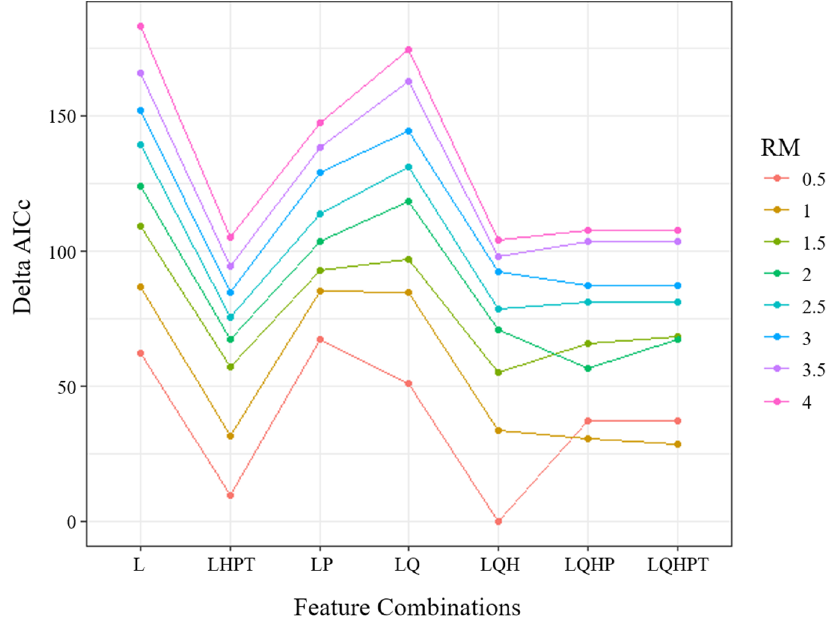
Figure 3. Delta-AICc values under different settings of the regularization multiplier (RM) and feature class combinations.